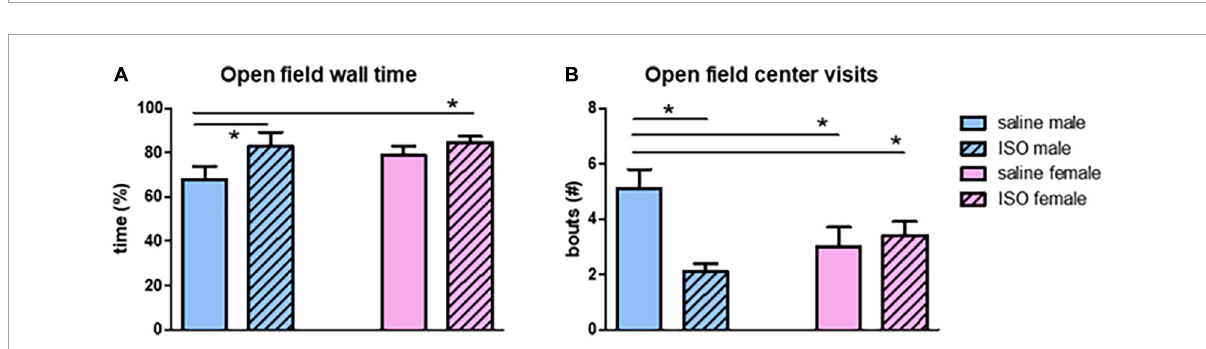
FIGURE6 Behavior in the open field test in the different experimental groups ( n = 8,7,7,10 in saline male, ISO male, saline female and ISO female rats, respectively). ISO, isoproterenol. *Significant difference between indicated groups ( p < 0.05). (A) Time spent at the wall; (B) number of visits to the